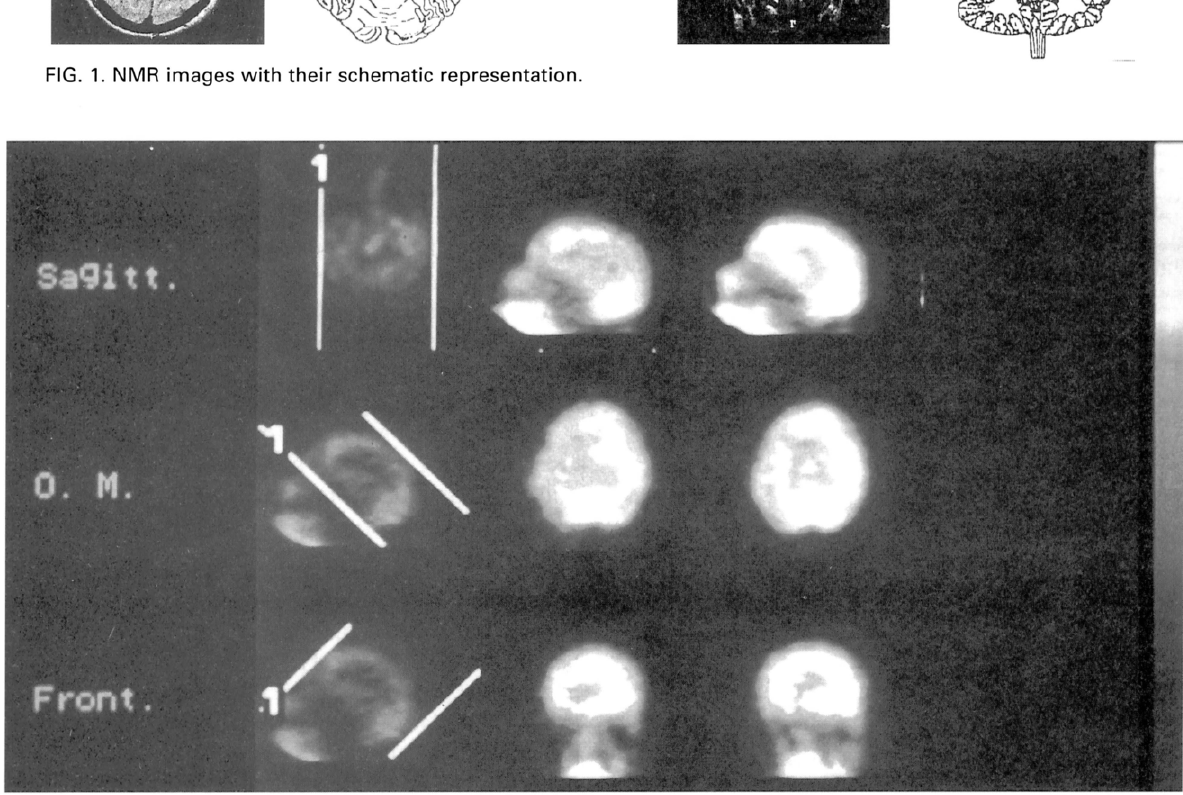
FIG. 1. NMR images with their schematic representation.